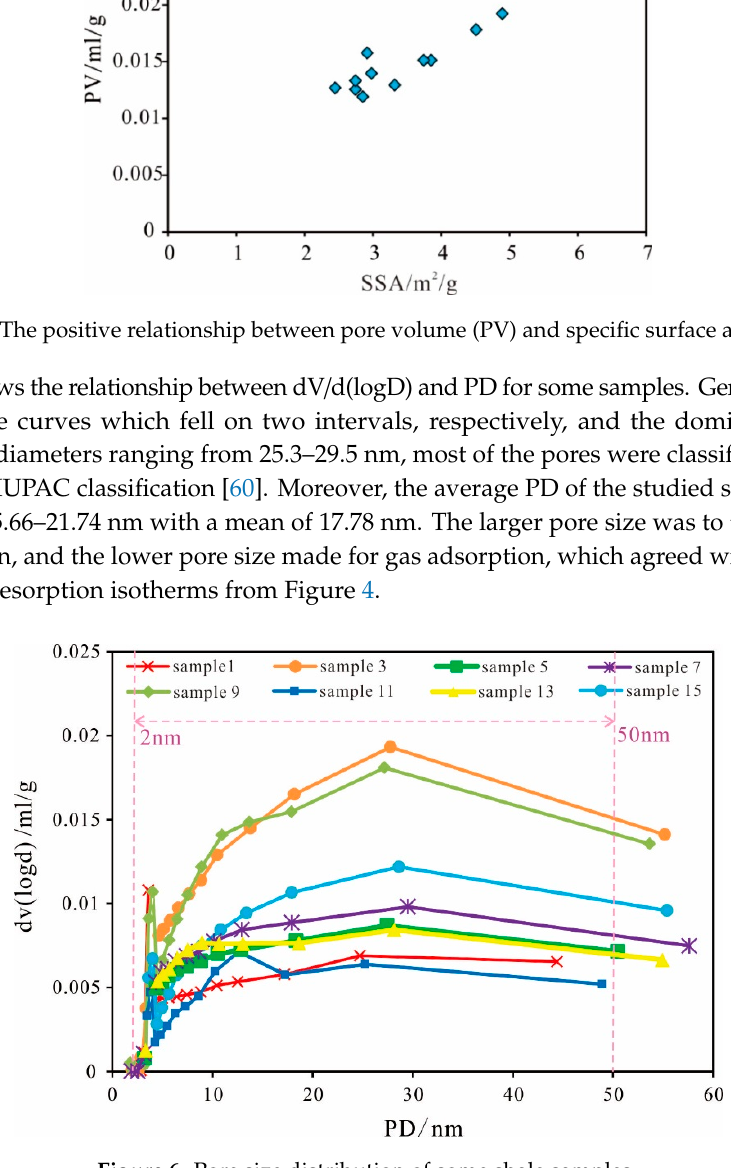
Figure 4. N 2 adsorption and desorption isotherms of two Yanchang shale samples. ( a ) N 2 adsorption